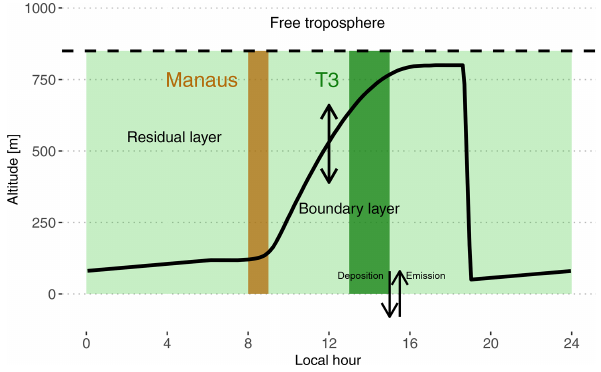
Figure 2. Schematic depiction of the box model setup used in this work. The continuous black line shows the time evolution of the PBL height. The dashed black line depicts the top of the residual layer box. The brown shaded area is the period when the box is sub- jected to Manaus emissions. For the rest of the time period, the box is subjected to biogenic emissions (light and dark green shaded ar- eas). The dark green shaded area is approximately the period when the box would be over the main instrumented site T3, assuming a travel time of 4 to